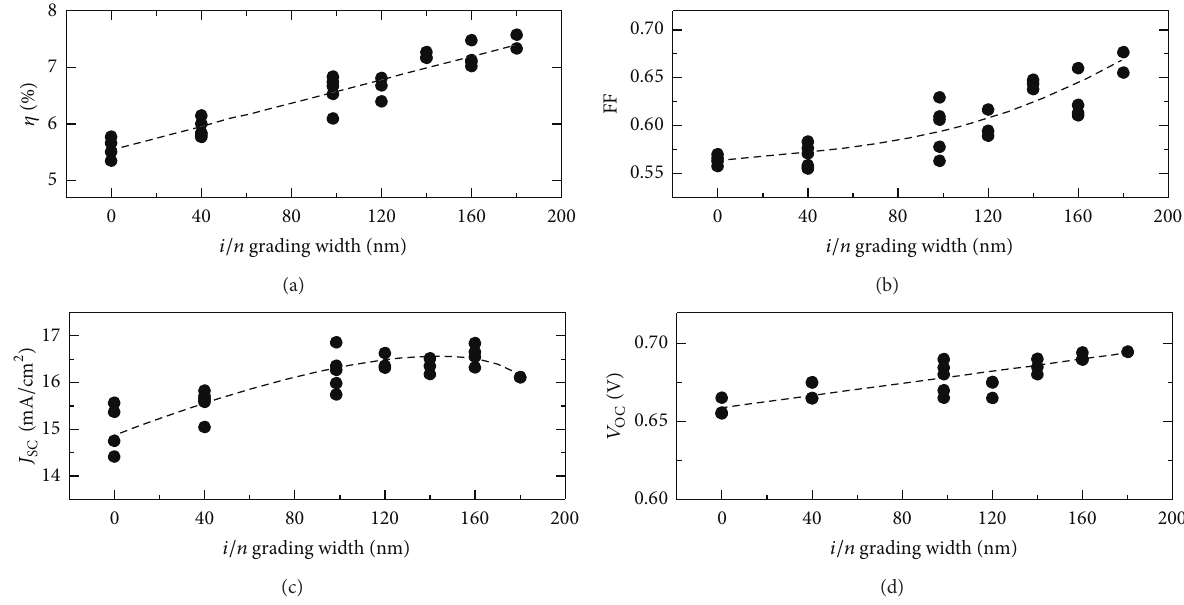
Figure 6: The performance of a-Si 1− Ge :H single-junction cells as a function of the i/n grading width under illumination of AM1.5G light x x source. The p/i grading width and the total thickness of absorber were 15 and 230 nm, respectively, for all the cells. The lines were drawn to guide the eye.